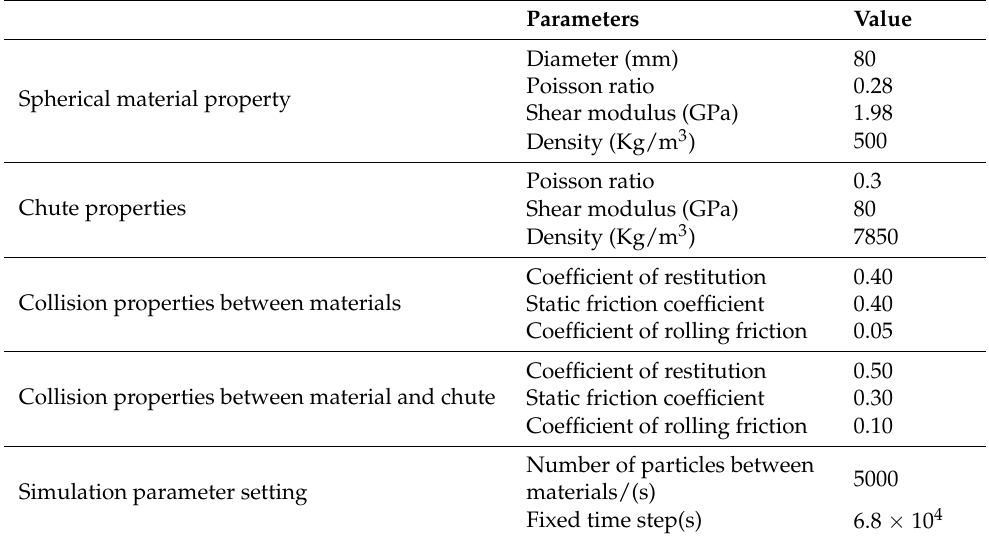
Table 1. Material properties and simulation settings.